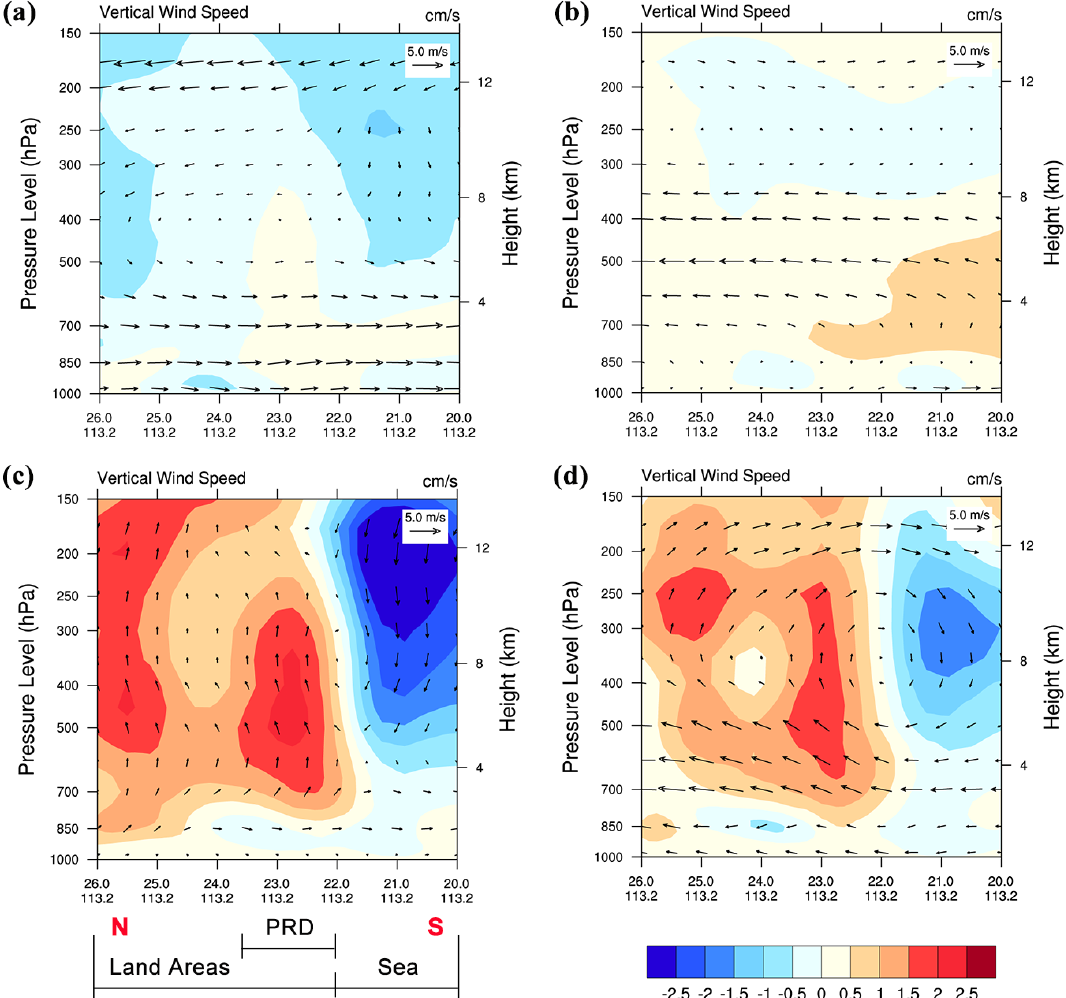
Figure 4. The cross sections of mean vertical wind field at 14:00LT for each scenario, i.e. (a) autumn (typhoon-induced), (b) autumn (no-typhoon), (c) summer (typhoon-induced) and (d) summer (no-typhoon). Cross sections were made along the 113.2 ◦ E longitude line, from 26.0 to 20.0 ◦ N (Fig. S4). The vectors indicate meridional wind speed (metres per second; hereafter ms − 1 ) and vertical wind speed (centimetres per second; hereafter cms − 1 ), and the contours indicate vertical wind speed (cms − 1 ). PRD is the Pearl River